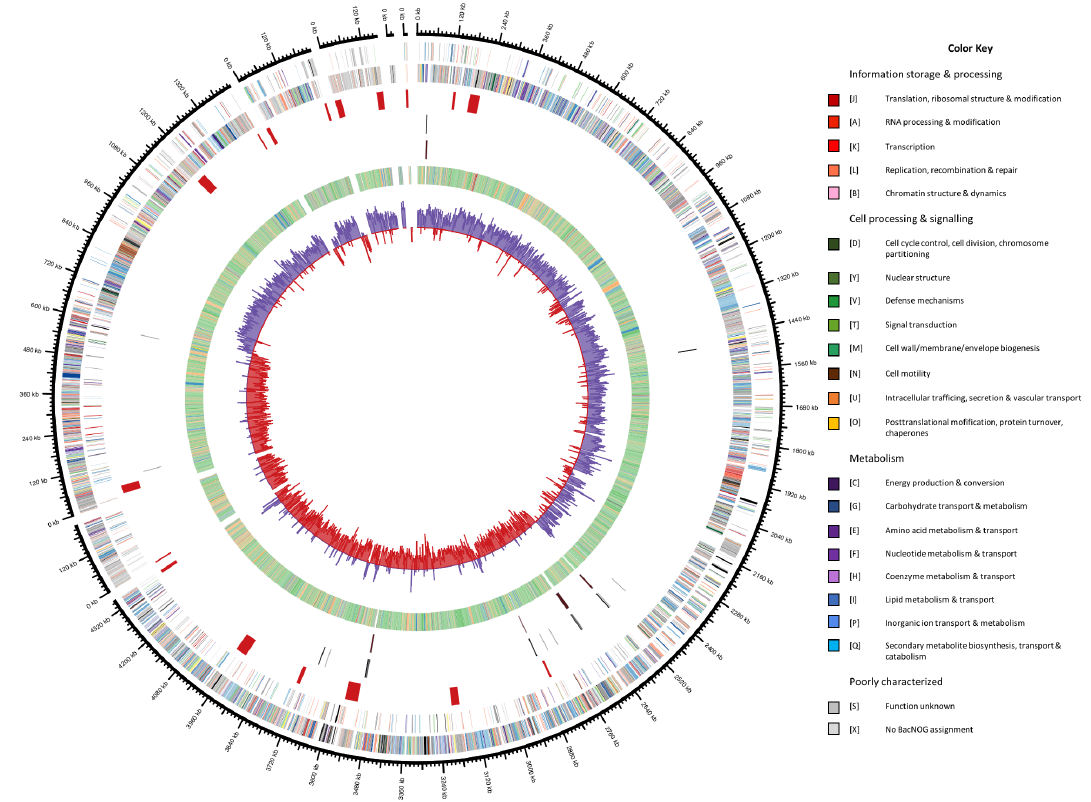
Figure 1. Circular representation of the V. alkaniphila L81 genome displaying relevant genome features. Contig order clockwise from top: 0, 5, 2, 6, 3, 7, 1. Circles representing the following (from center to outside): 1, G + C skew [(G − C)/(G + C) using a 2-kbp sliding window] (blue, positive; red, negative); 2, Taxonomy by Uniref90 top hits; Firmicutes (green), Archaea (red), Eukaryota (yellow), other Bacteria (blue), unknown (orange), no hit to Uniref90 (grey). 3, tRNAs (black); 4, rRNA operons (dark red); 5, Prophages; 6, Coding DNA sequence (CDS) on the reverse strand; 7, CDS on the forward strand. Color coding of CDS was based on COG categories. The figure was build using Circos version.